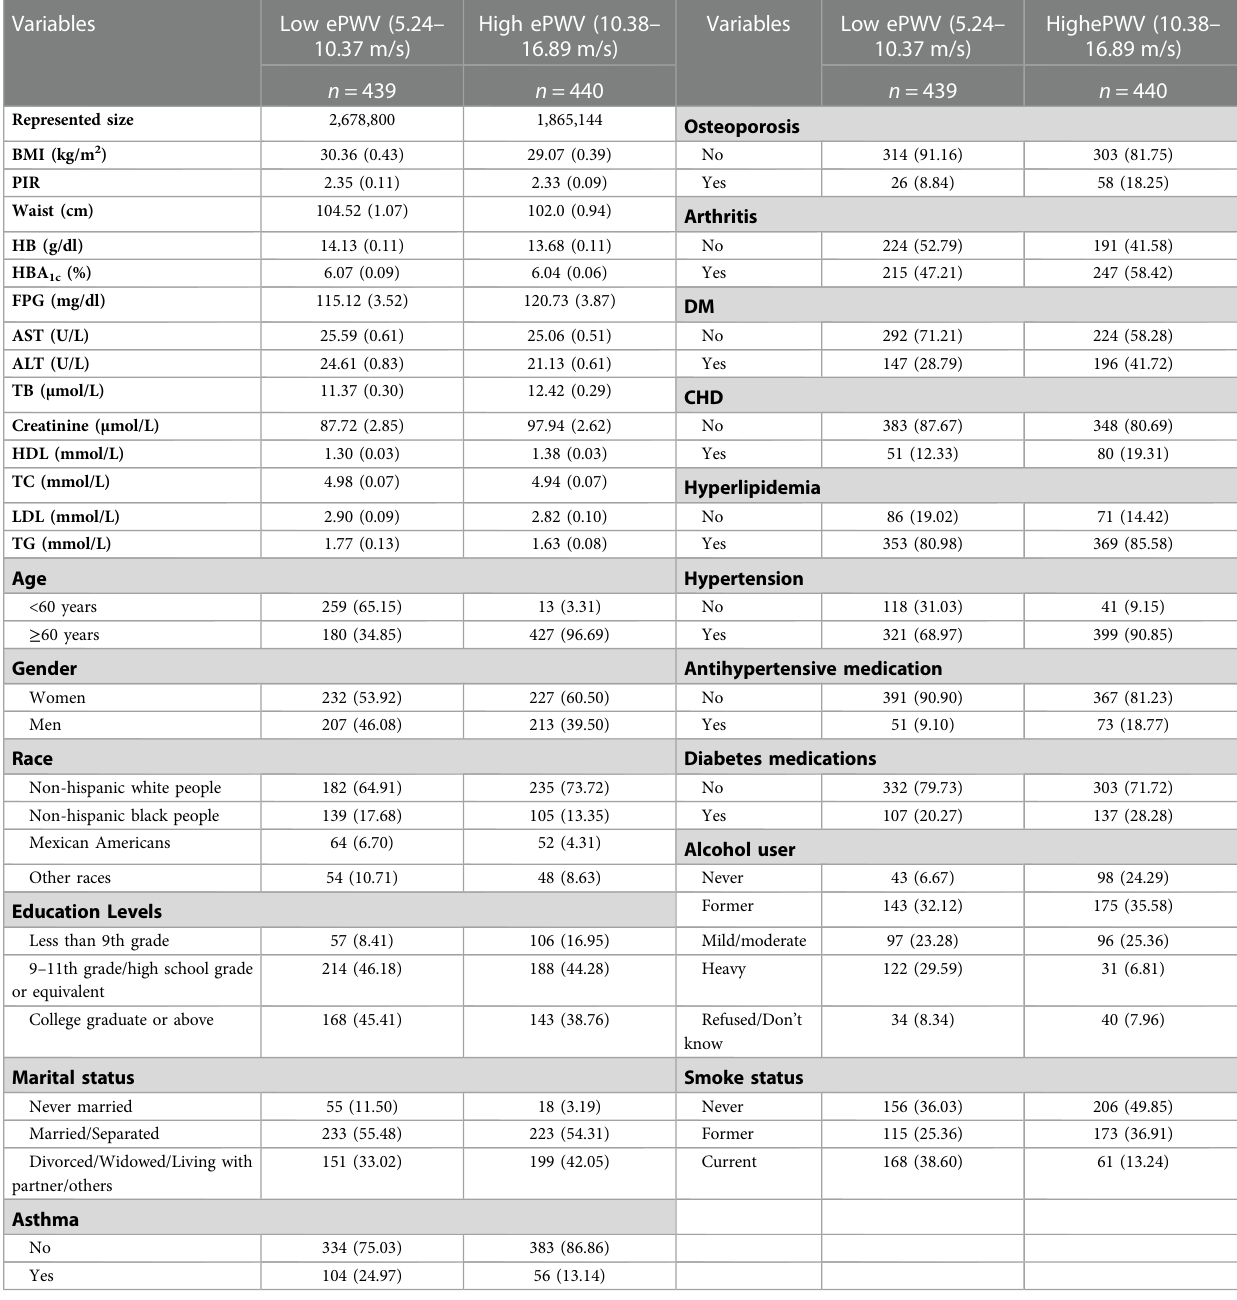
TABLE 1 Survey-weighted baseline characteristics of stroke patients (representing 4,543,943 individuals) strati fi ed by ePWV median